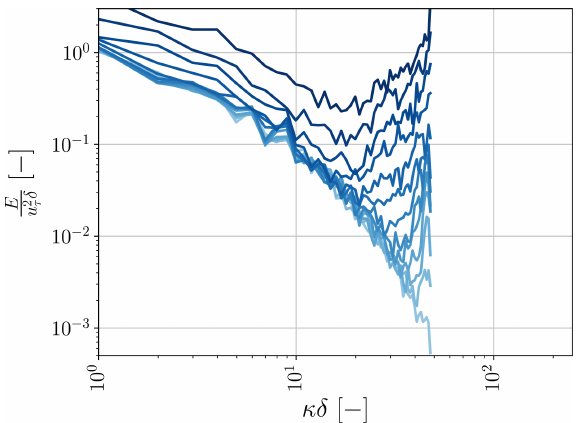
Figure 15. Time evolution of stream-wise spectra averaged in the span-wise direction, where the colour brightness indicates the dif- ferent time steps. Here, the light blue colours refer to the first time steps, and the dark blue colours to the final time steps. The time steps range from t = 0s to t = 36s, with intervals of